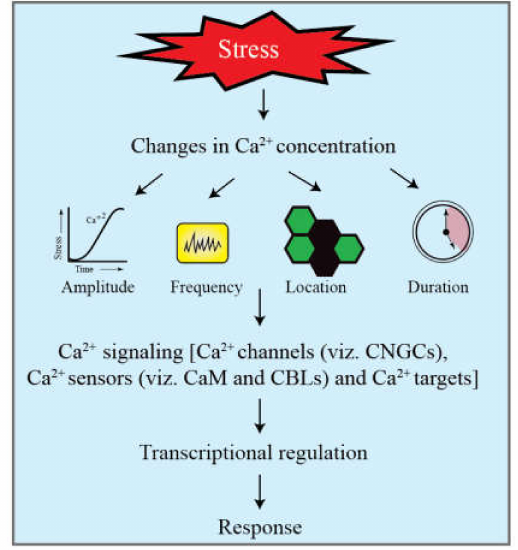
Figure 2. A simplified model of calcium signaling in plants. Calcium has a unique ability to adjust itself in the cytosol at the time of stress or optimal growth challenges. Its occurrence per period, time span, magnitude and location oscillates with the kind and the degree of stress. Ca 2+ signals are further decode by calcium sensors resulting in the transcriptional regulation and ultimately stress